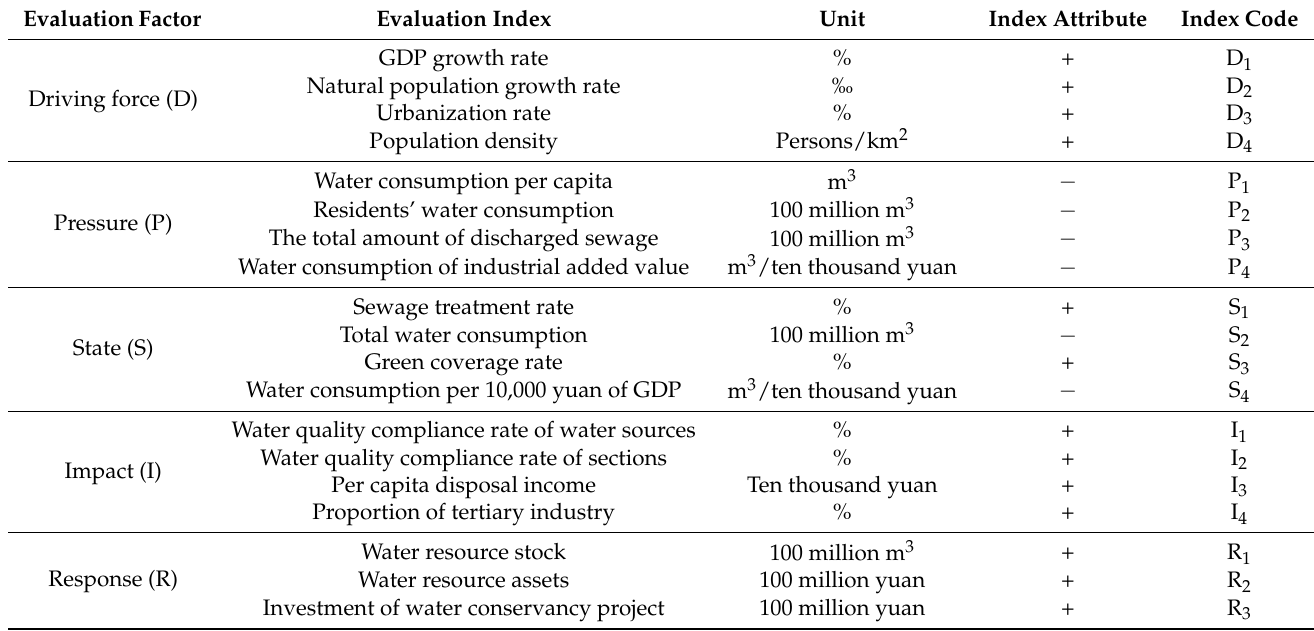
Table 1. Evaluation index system of water resource carrying capacity in Zhengzhou based on DPSIR